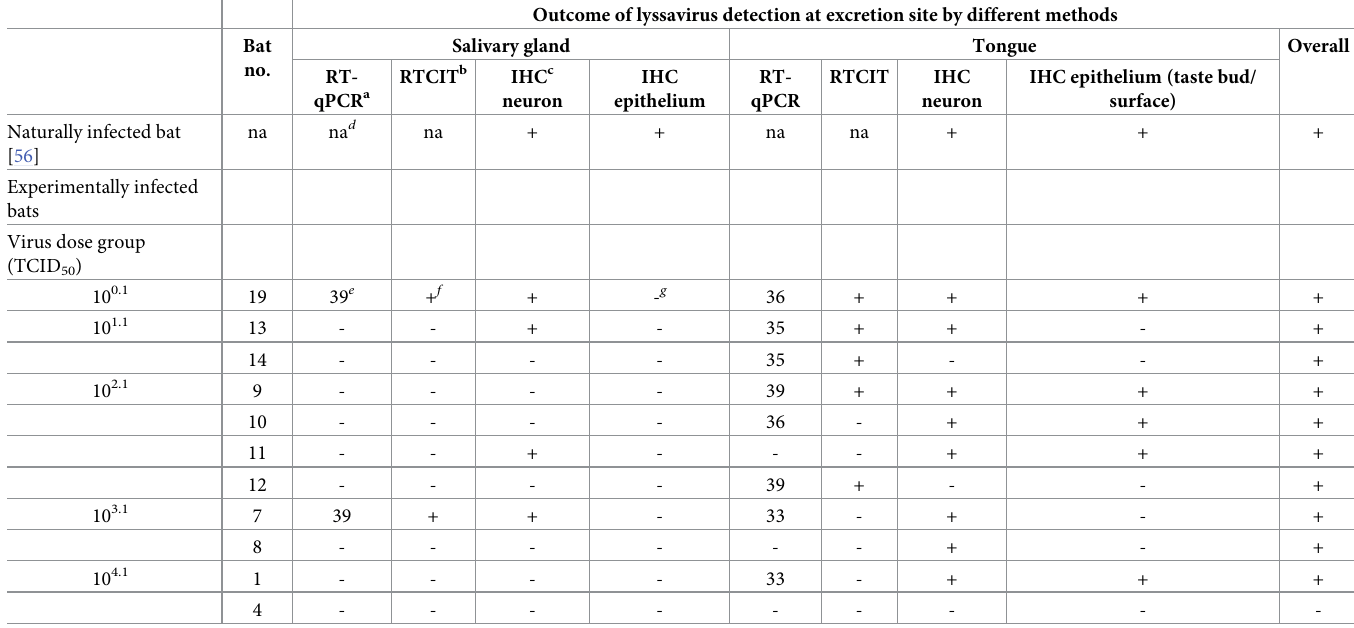
Table 3. Evidence for lyssavirus infection, based on different methods, at excretion sites in straw-colored fruit bats with Lagos bat virus-positive brains. Outcome of lyssavirus detection at excretion site by different methods Bat